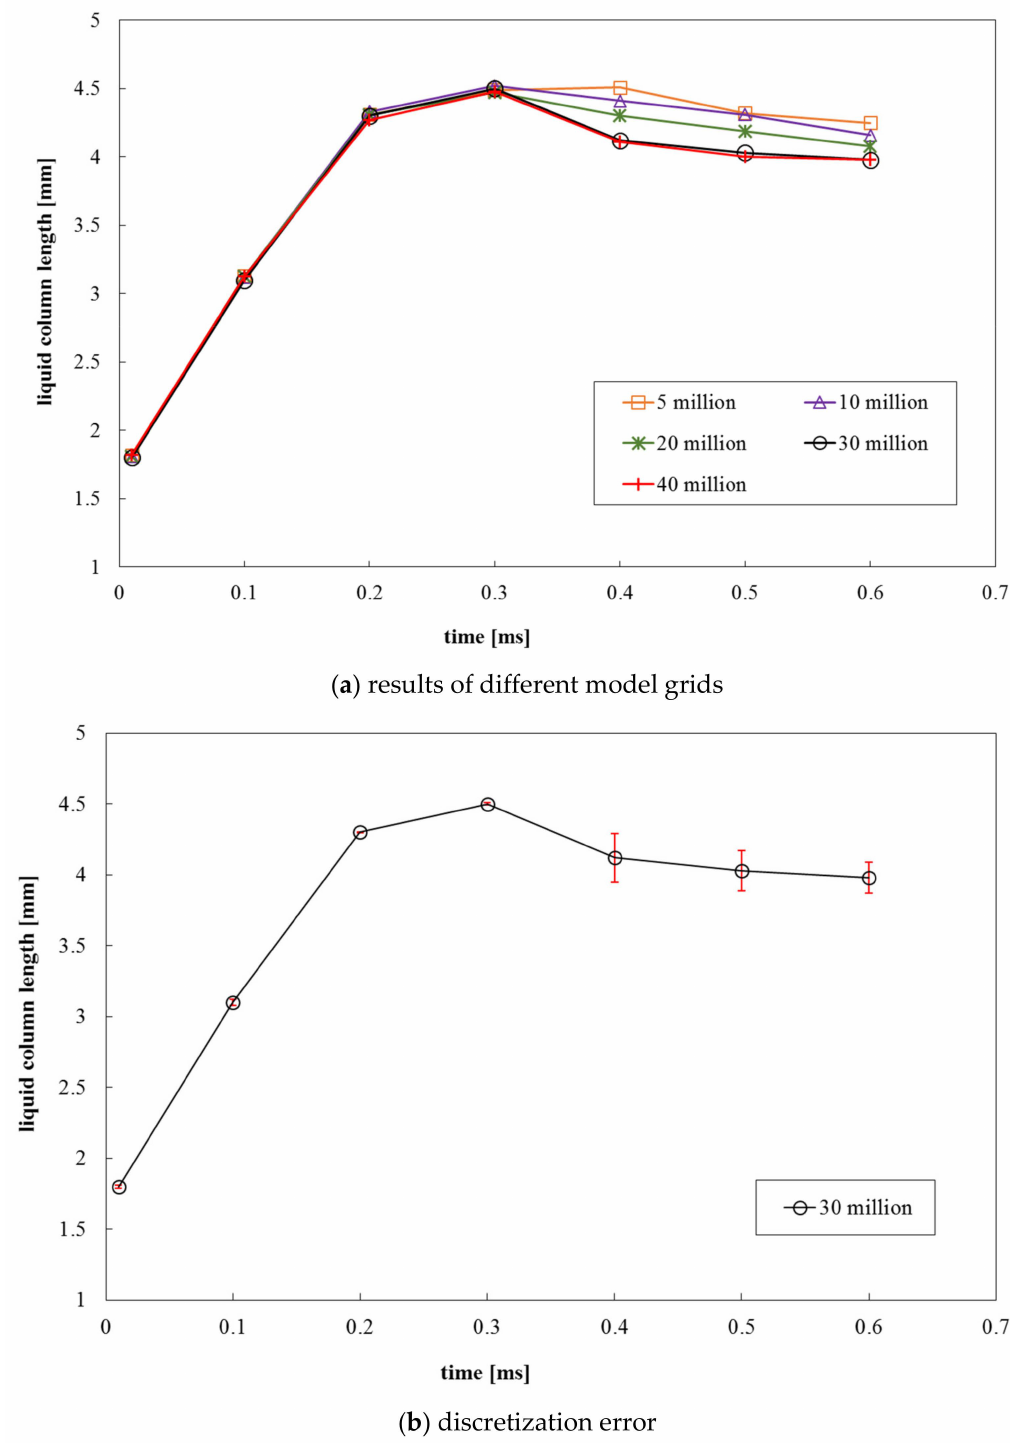
Figure 4. Grid independency